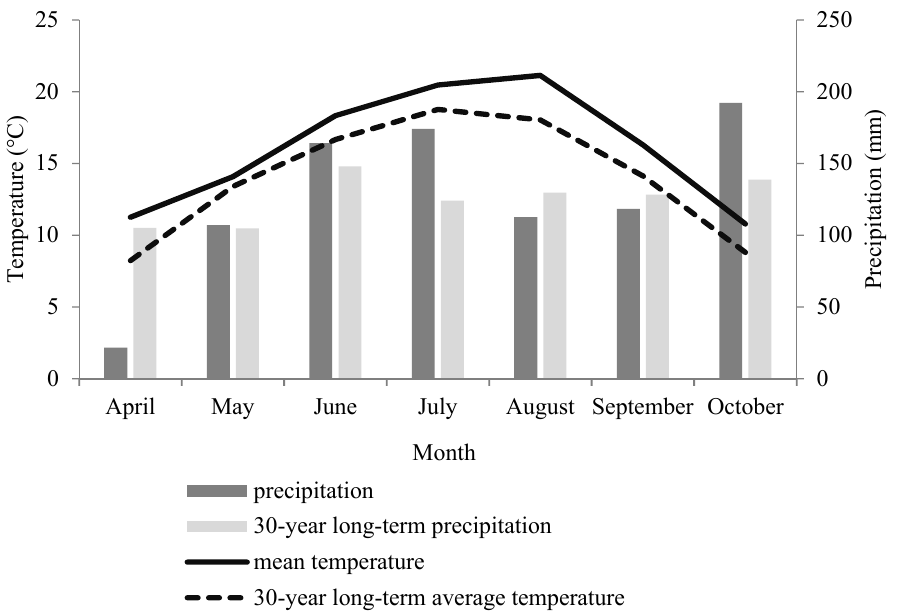
Figure 1. Mean temperature and precipitation for the experimental field in Jablje during 2020.